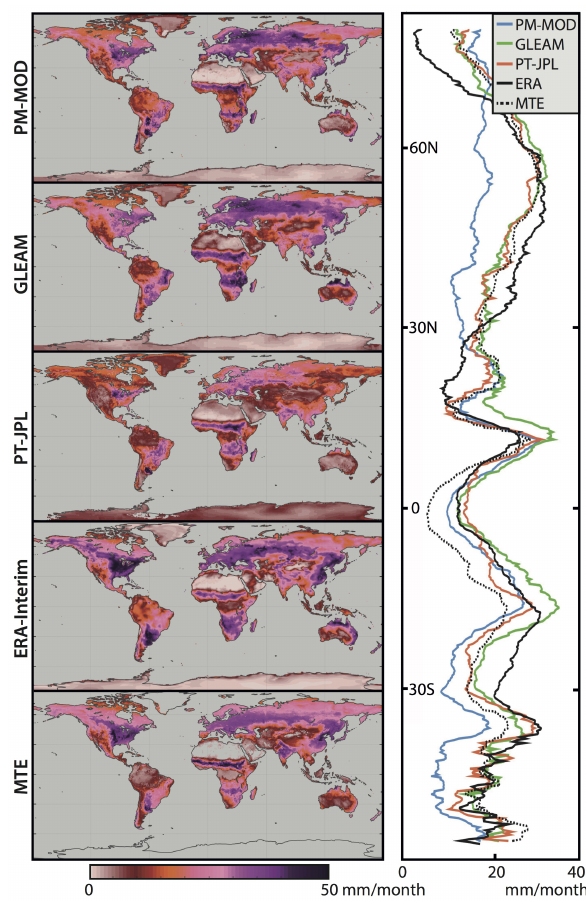
Figure 5. Standard deviation of land evaporation, based on the monthly time series for 2005–2007 at each pixel for PM-MOD, GLEAM, and PT-JPL forced by the reference input data set; the ERA-Interim reanalysis and the MTE product are shown for com- parison. The right column illustrates the latitudinal profiles of these standard deviations. Due to the MTE product not reporting values in polar regions and deserts, these areas are excluded from the lati- tudinal profiles in all